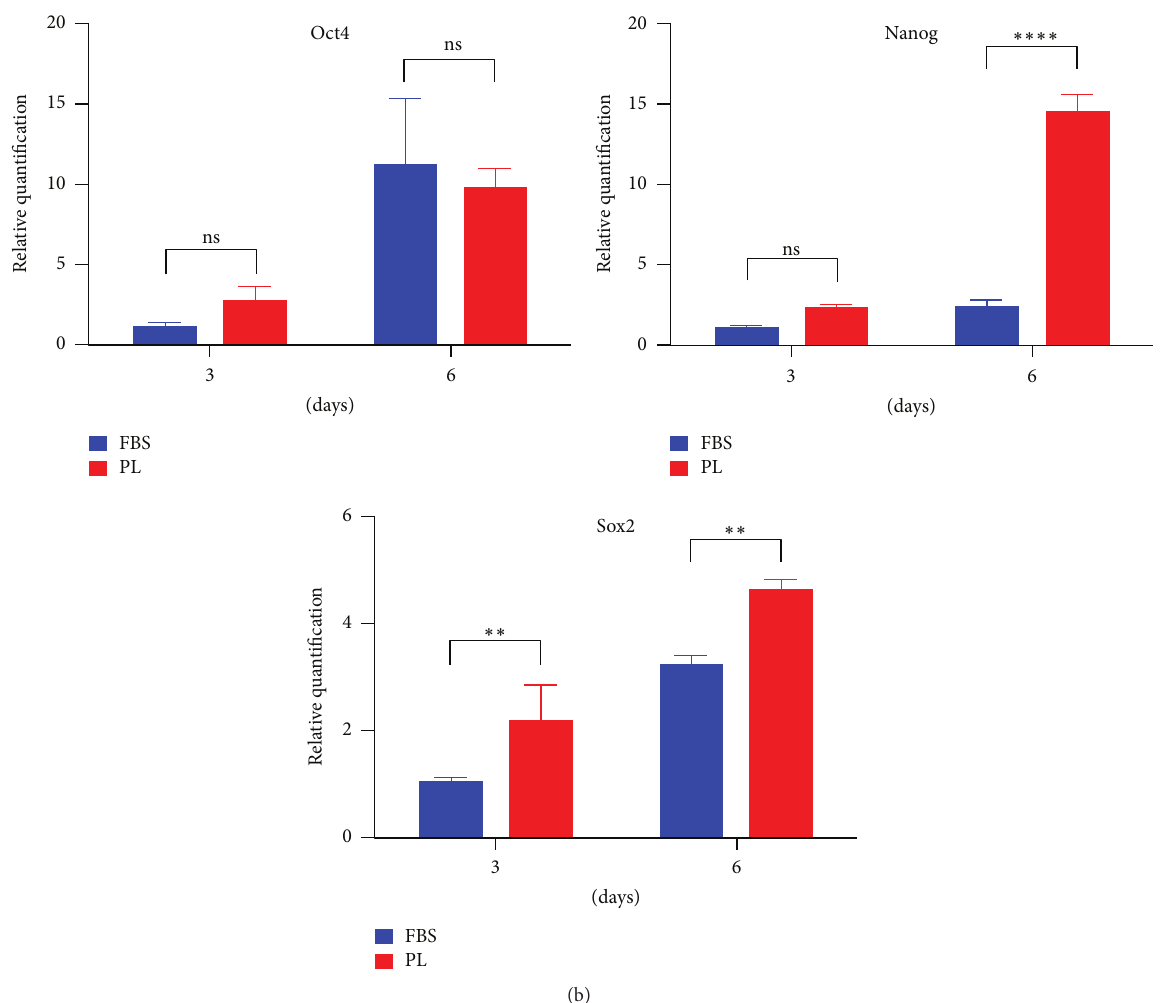
Figure 2: Stem cell markers comparison between FBS and PL cultures of DPSCs. (a) Immunophenotype for expressed MSC surface markers by flow cytometric analysis. The number specifies the percentage of gated cells positive for the indicated protein. Data representative of two experiments. (b) Relative levels of transcripts (fold change) for stemness markers derived from real-time PCR analysis. Statistical significance determined by 2-way ANOVA ( ∗ 𝑃 < 0.05 ; ∗∗ 𝑃 < 0.01 ; ∗∗∗ 𝑃 < 0.001 ; ∗∗∗∗ 𝑃 < 0.0001 ), mean + SD, 𝑛 = 3